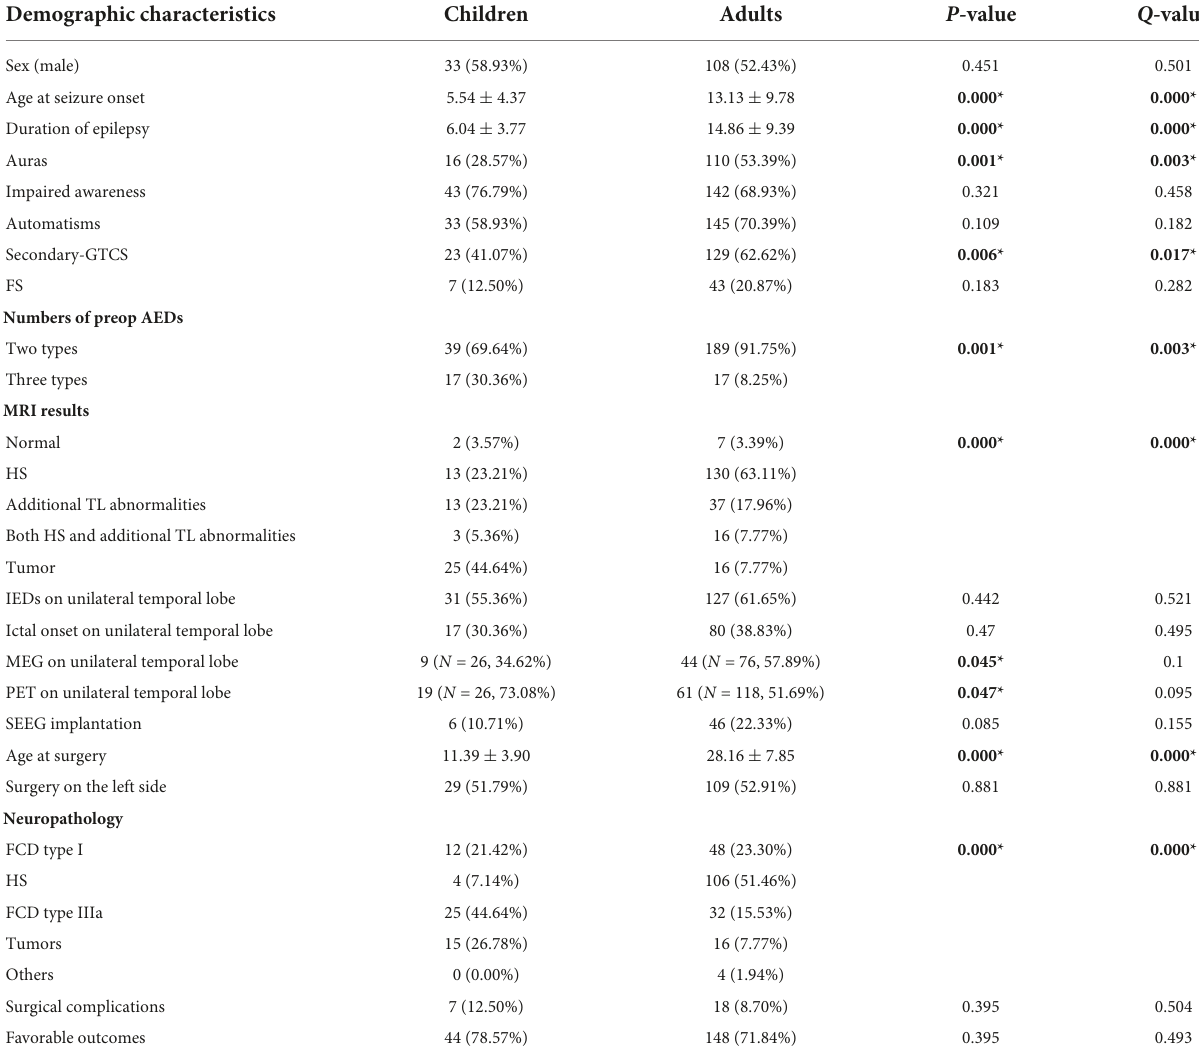
TABLE 1 The difference in demographic characteristics between temporal lobe epilepsy (TLE) children and adults. Demographic